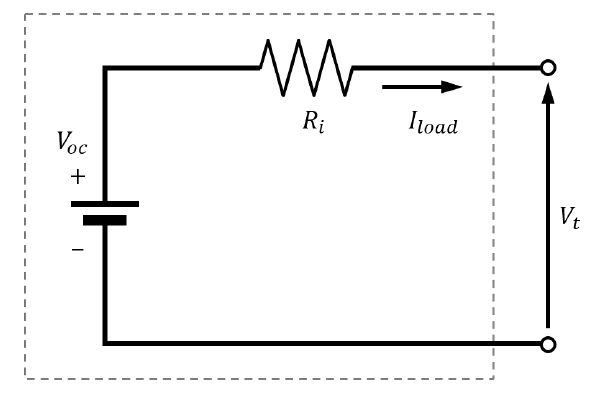
Figure 10. Simple battery